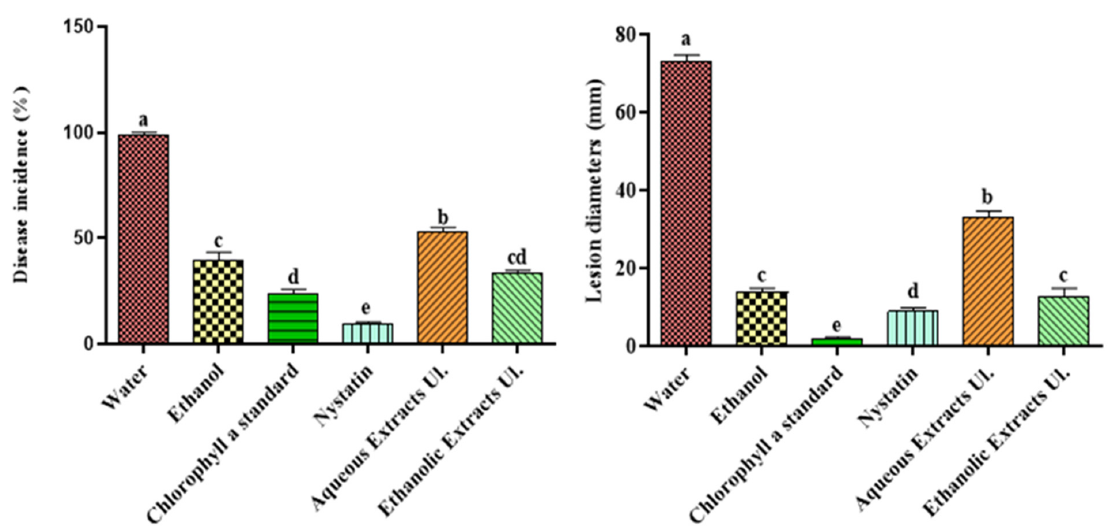
Figure 1. Disease incidence and severity (lesion diameter) caused by P. digitatum (suspension of 10 4 spores · mL –1 ) for oranges treated with aqueous and ethanolic extracts of Ulva lactuca and with an ethanolic solution of chlorophyll a, 14 days after inoculation. Columns (means) with different letters are significantly different: p < 0.05 (Duncan’s test).